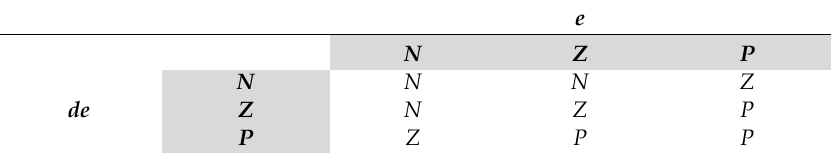
Table 4. Rule base of the fuzzy logic controller.